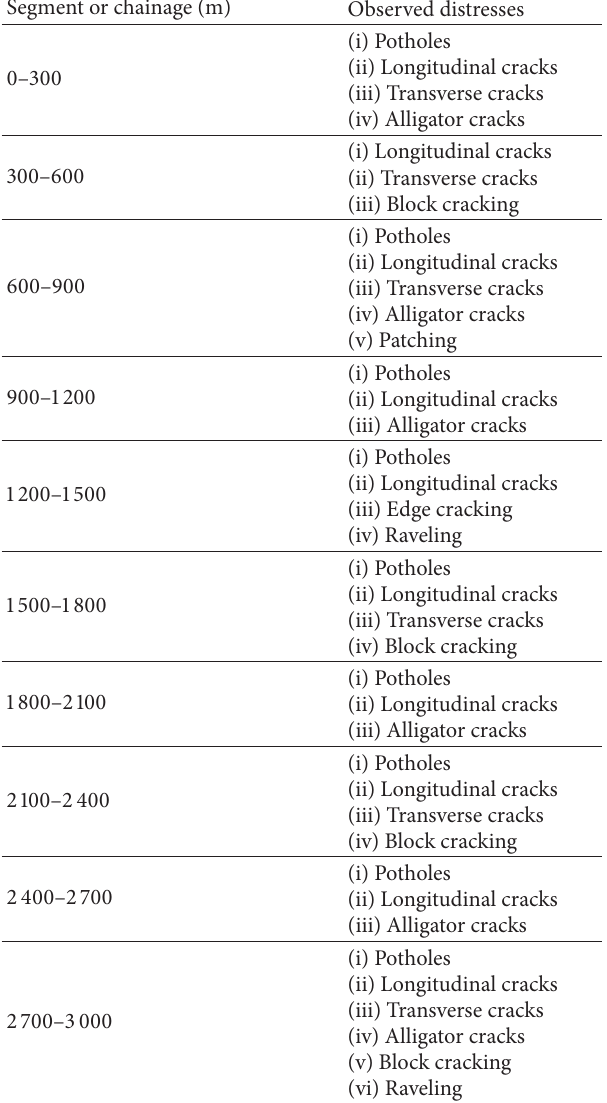
Table 1: Road condition survey data showing pavement segment chainage and the observed distresses, as derived from the PQI